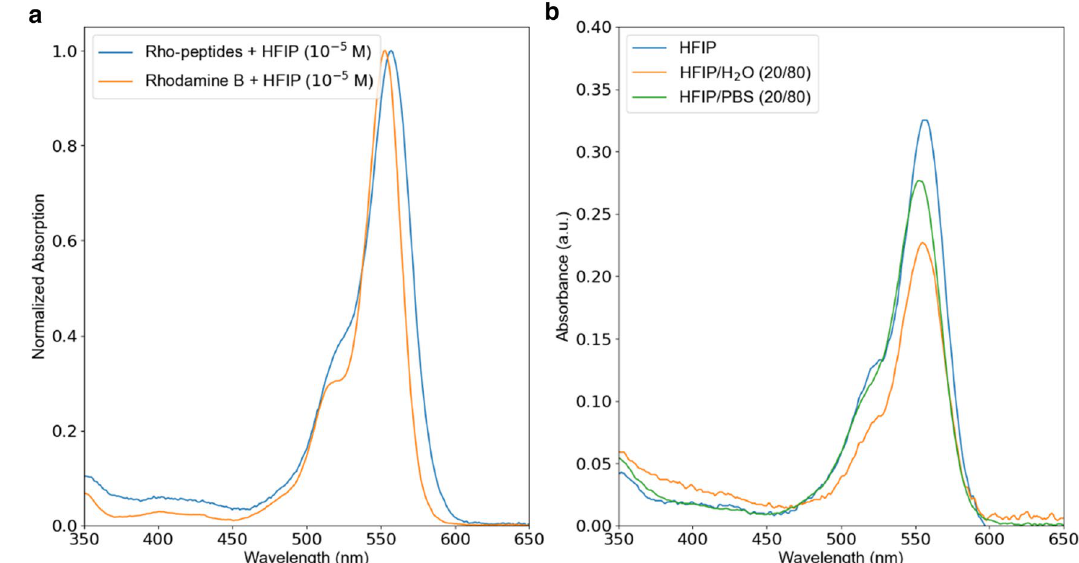
Figure 3. ( a ) Absorbance spectra—Rhodamine B (blue line) and Rho-peptide (orange line). The dyes are dissolved in HFIP with a molar concentration of 10 −5 M. ( b ) Absorbance spectra of Rho-PEG1300-F6 in HFIP, HFIP/H 2 O (20/80) and in HFIP/PBS (20/80) at pH 7.4. Spectra are recorded between 350 and 650